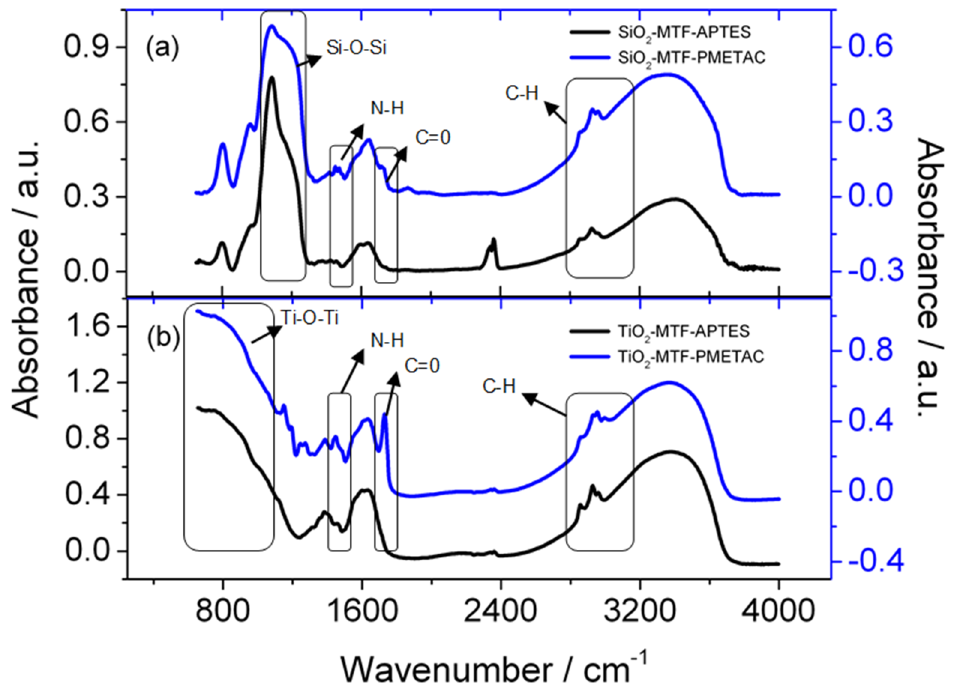
Figure 3. DRIFTS measurements for silica ( a ) and titania ( b ) mesoporous thin films before (black) and after polymerization (blue). The wavenumber region of the most relevant absorption bands of selected functional groups have been outline for clarity.